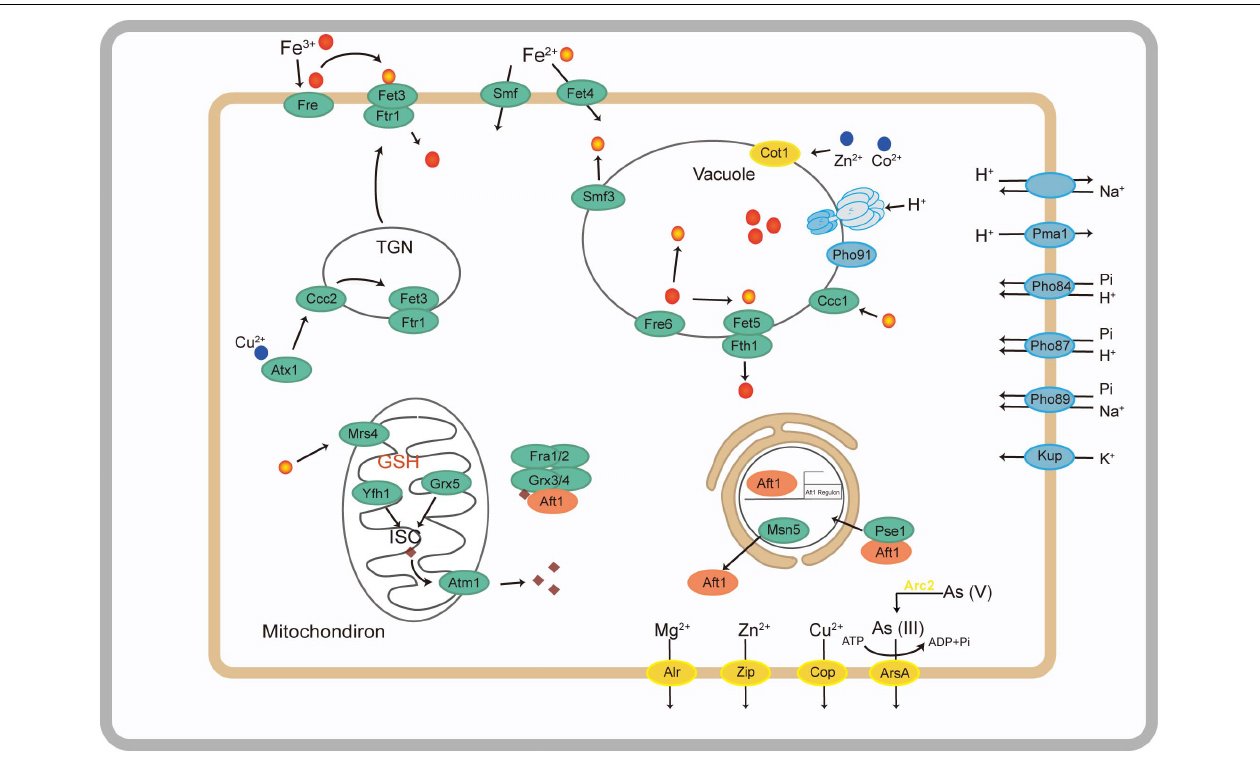
FIGURE 5 | Metabolic abilities associated with putative iron utilization pathway (green), stress response (blue), and other metal transporters (yellow) of A. bohemica based on the genes predicted from its draft genome.